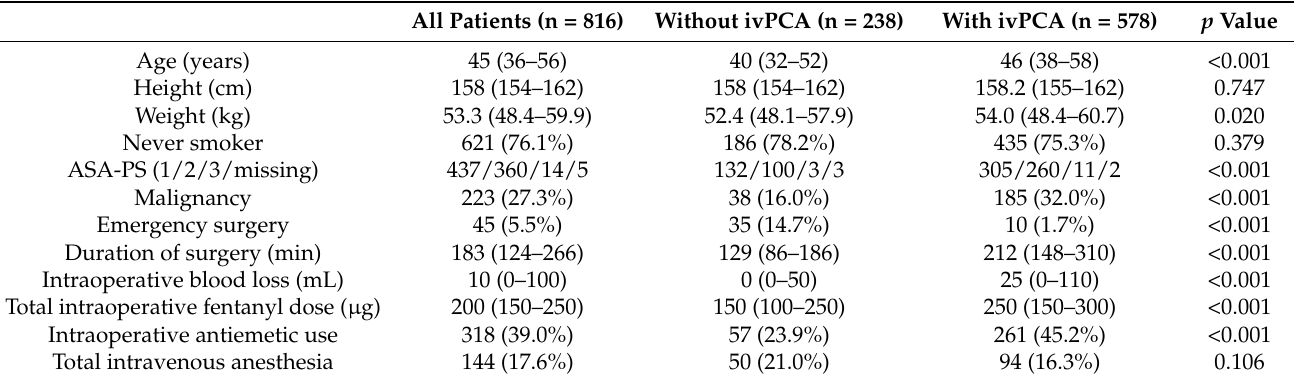
Figure 1. Flow diagram of the study participants. ICU, intensive care unit; ivPCA, intravenous patient-controlled analgesia. Table 1. Patient characteristics and operative variables by ivPCA